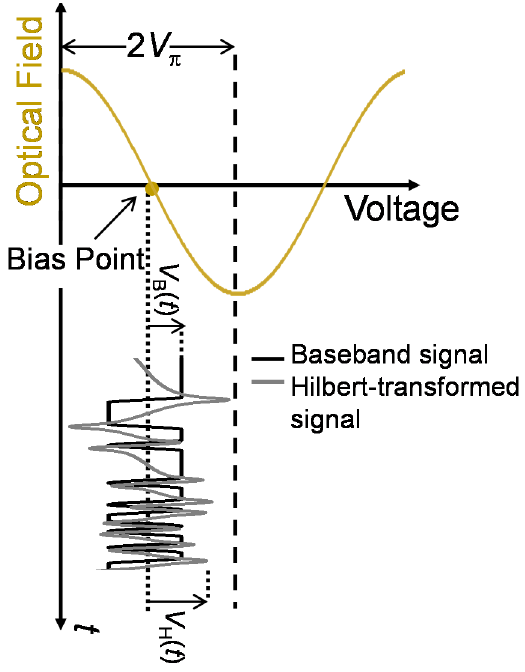
Figure 2. The operation condition of IQ modulator.